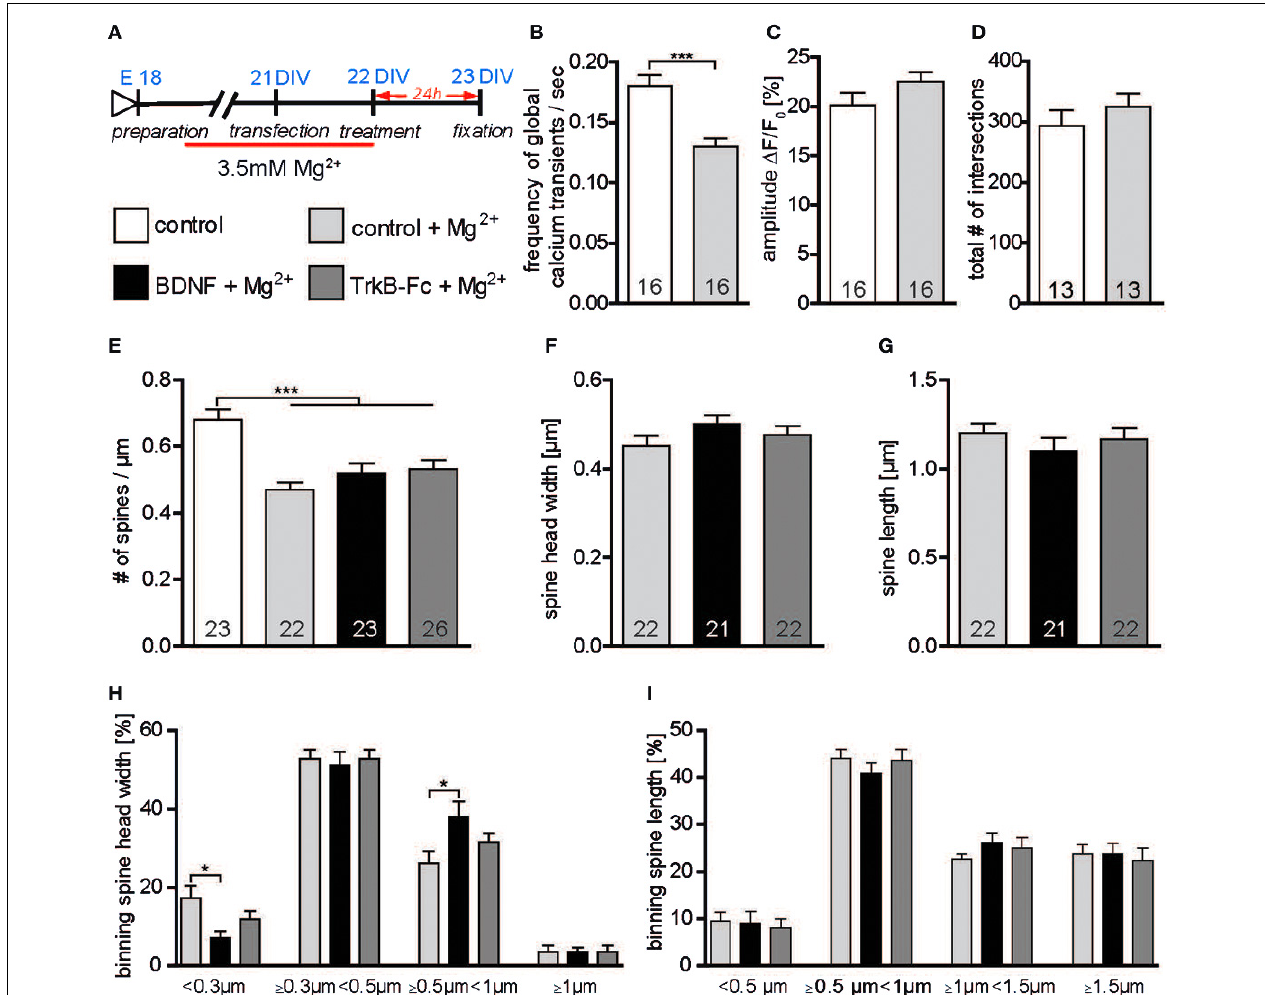
FIGURE 6 | (A) Experimental timeline. Primary neurons werecultivatedfor 2 weeksinhigh(3.5mM)Mg 2 + mediumandtreatedwithBSA(control),BDNFor TrkB-Fc inlow(1.5mM) Mg 2 + . (B) Graphcomparing thefrequency of calcium transients inhippocampal primaryneurons cultivatedinhighor lowMg 2 + containingmedium. (C) Graphcomparingtheamplitudeofcalciumtransientsin hippocampal primaryneurons cultivatedinhighorlow Mg 2 + containing